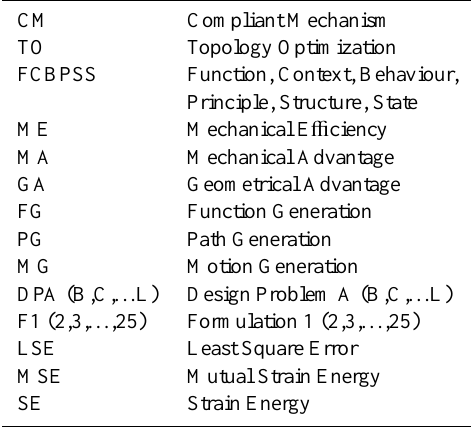
Table A1. List of